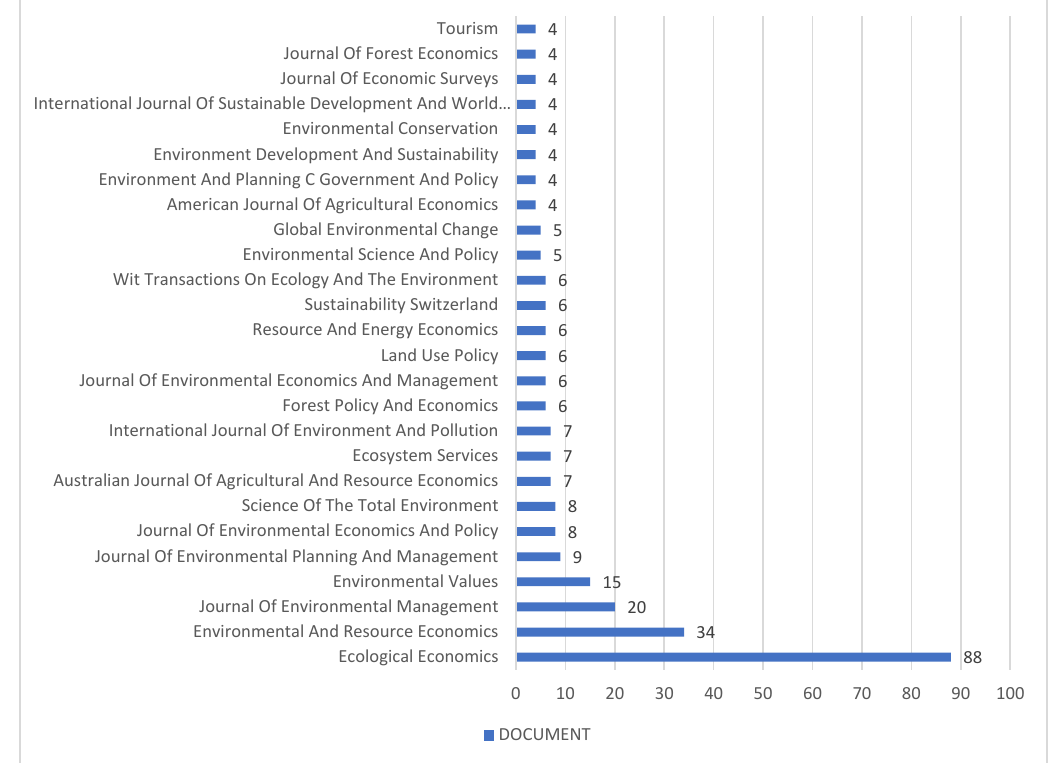
Figure 5. Document per year by source.